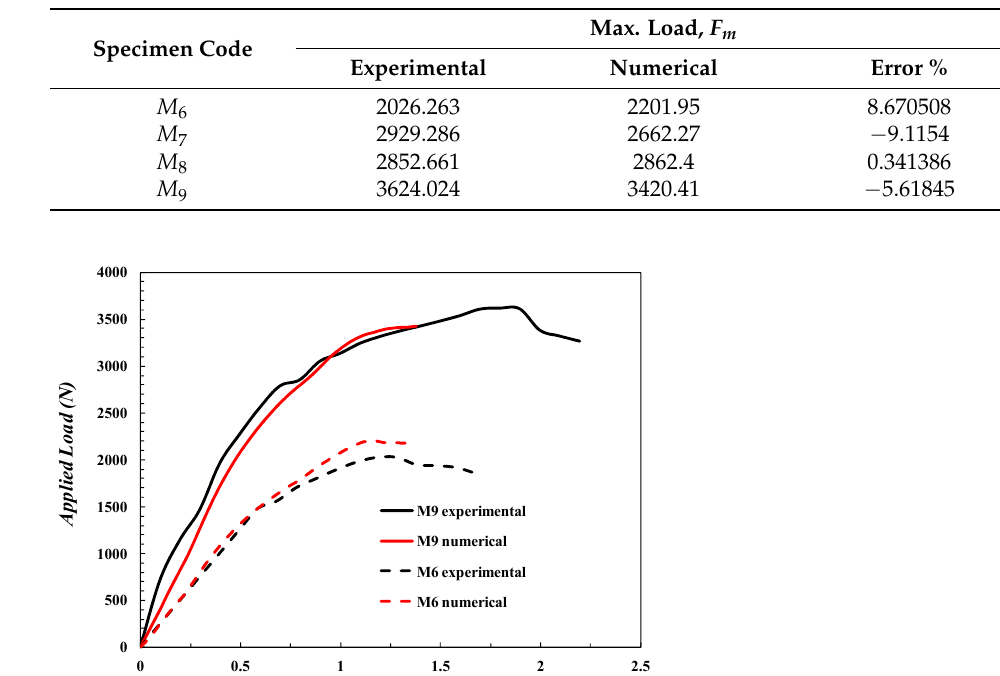
Table 6 . Experimental and numerical maximum applied load (N). Table 6. Experimental and numerical maximum applied load (N).